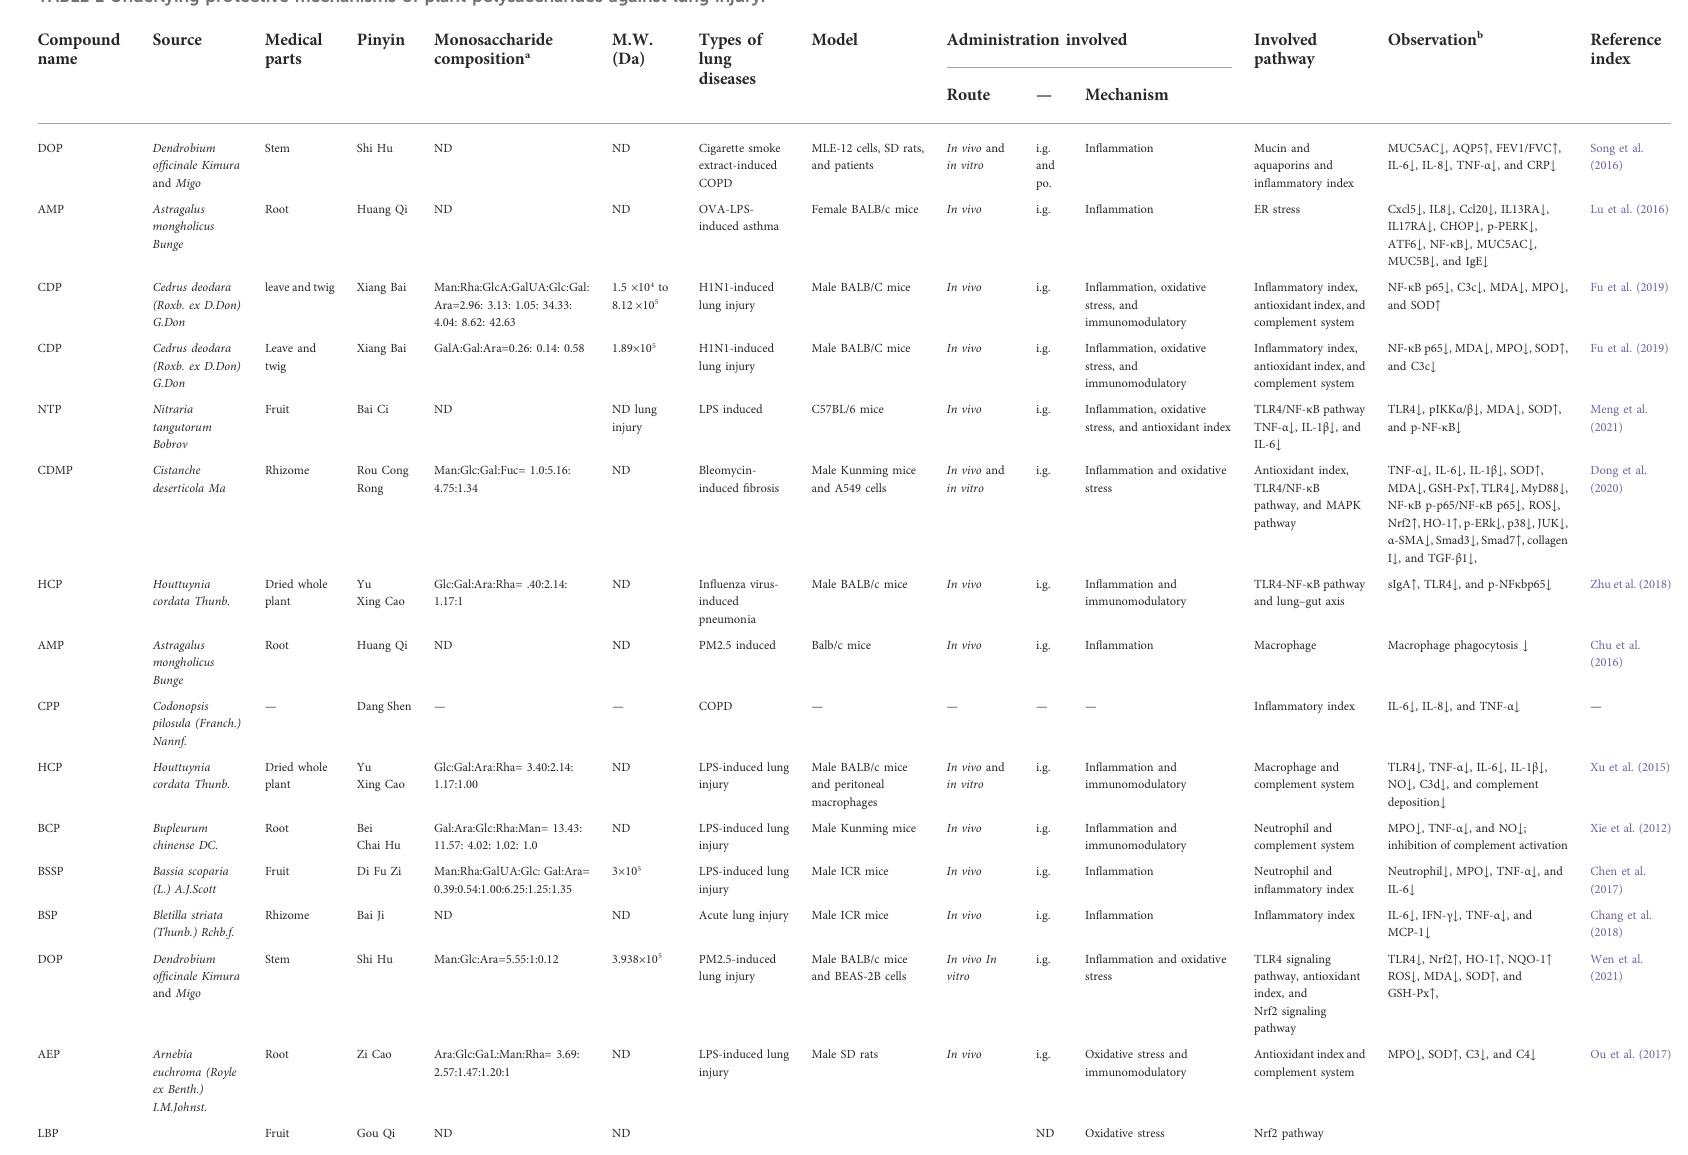
TABLE 1 Underlying protective mechanisms of plant polysaccharides against lung